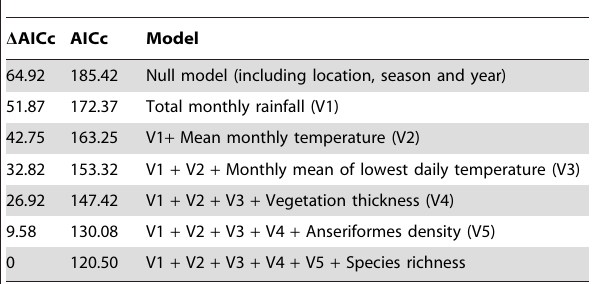
Table 6. Variables retained in the final model for avian influenza virus prevalence, their coefficients, Wald test values and significance